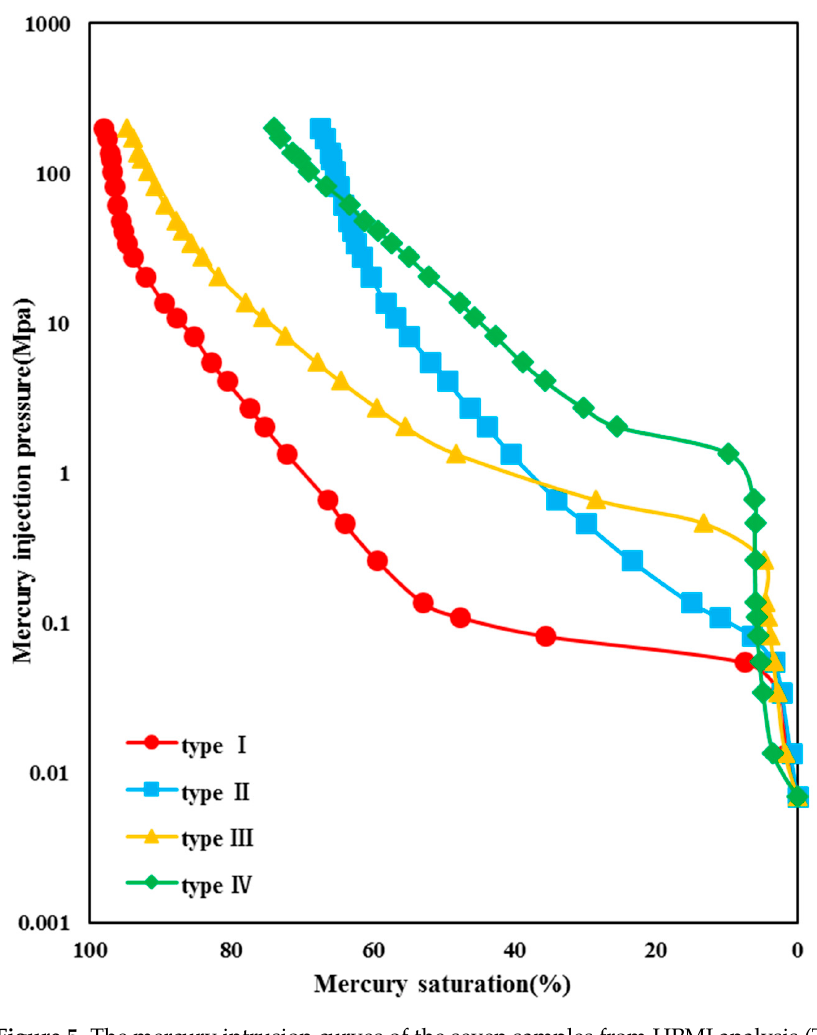
Figure 5. The mercury intrusion curves of the seven samples from HPMI analysis (Type I: Sample 5;